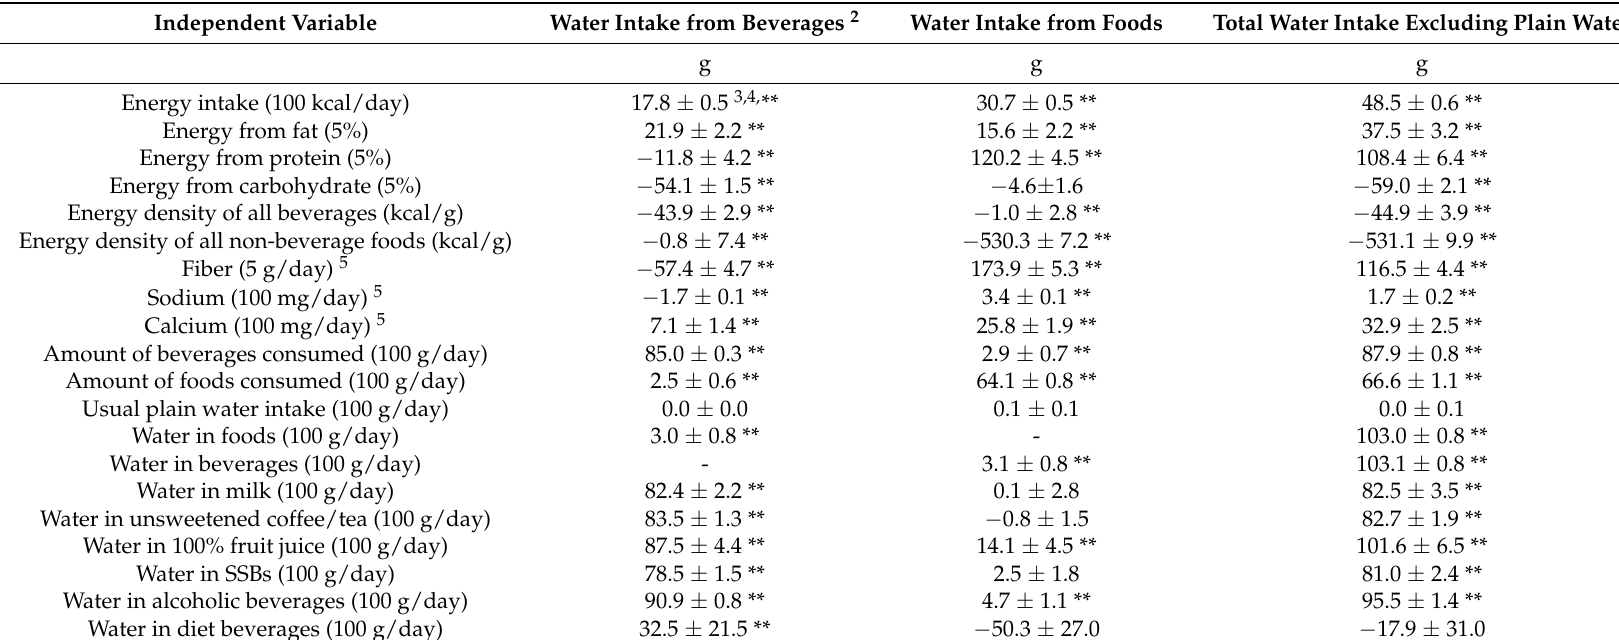
Table 3. Water intakes from beverages and foods associated with energy and nutrients intakes in Korean adults, KNHANES 2008–2012 1